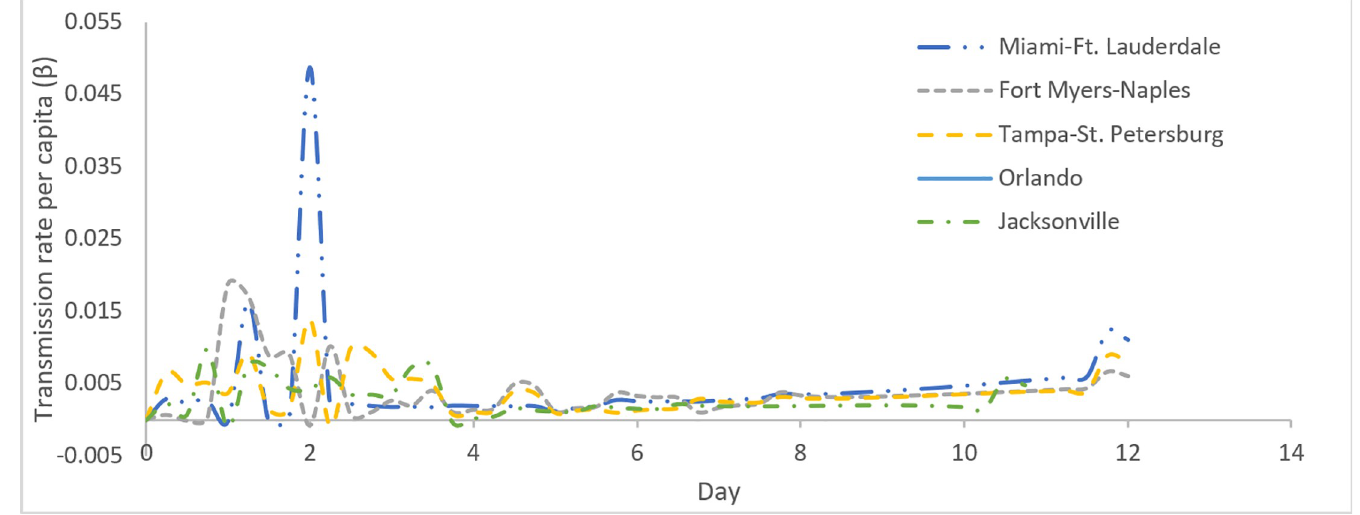
Fig 5. Transmission per capita rate ( β ) for the city/areas effected by Hurricane